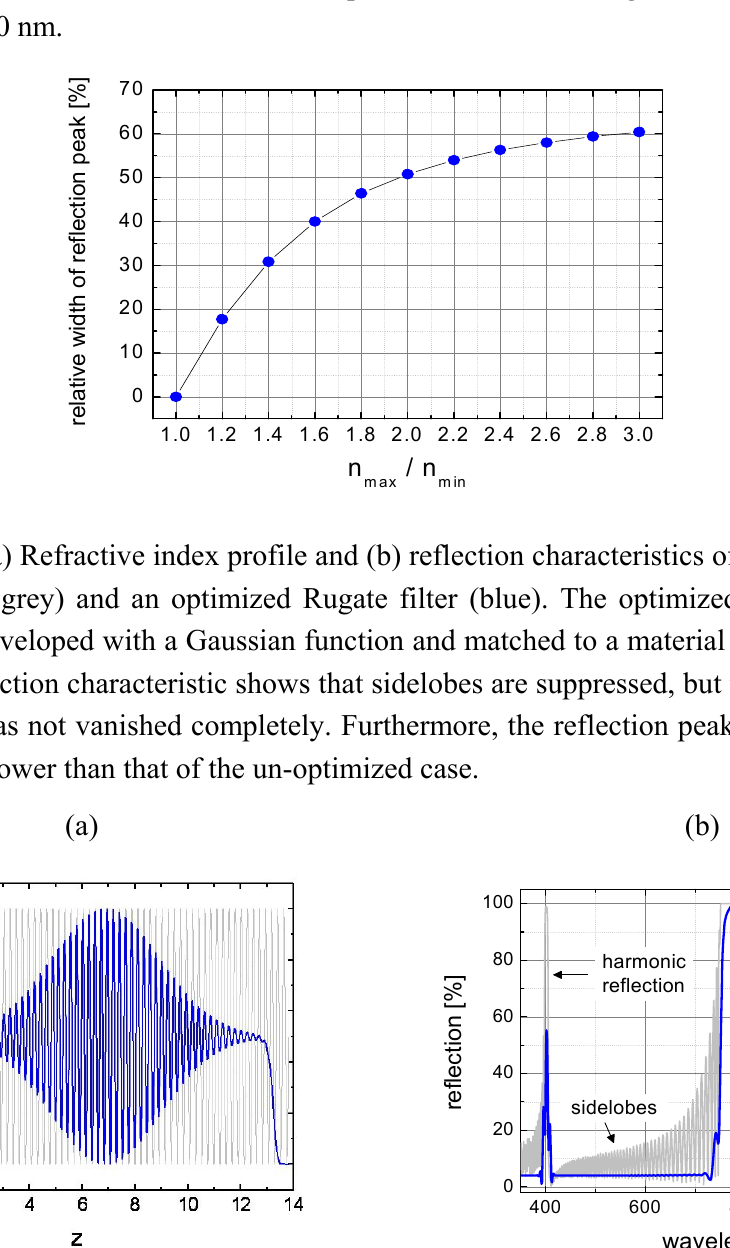
= 800 nm, the width of 0 = 700 nm −